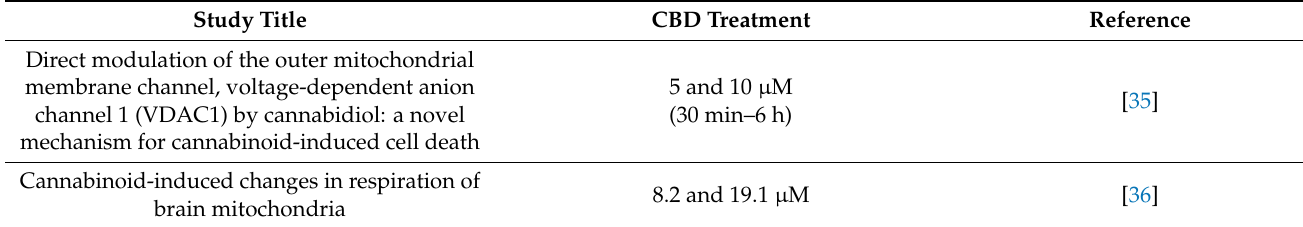
Table 1. CBD treatment range of all in vitro